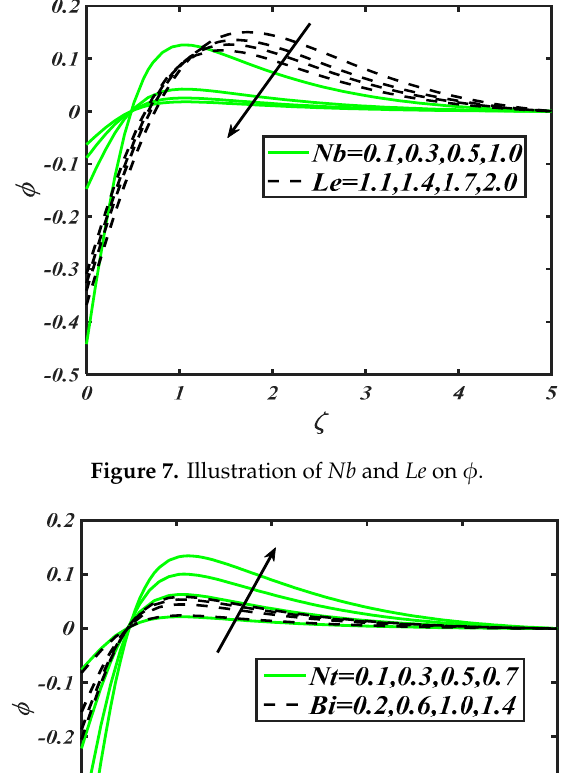
Figure 6. Illustration of Nt and Bi on